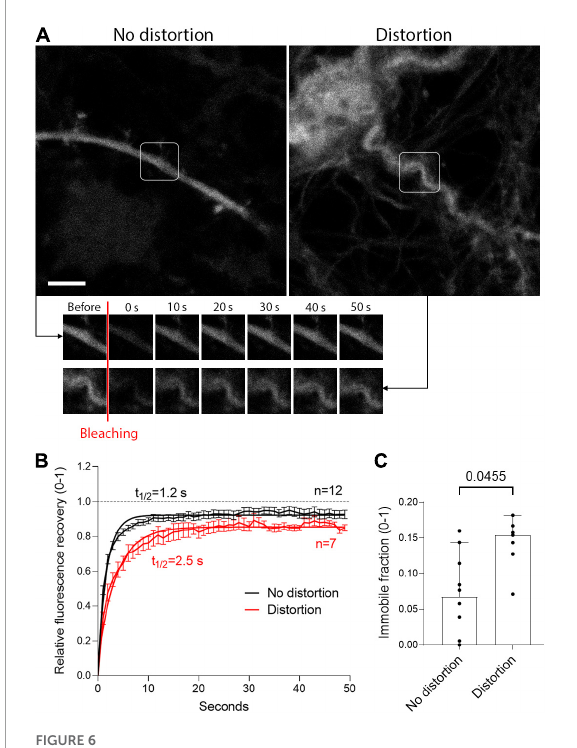
FIGURE6 Delayed diffusion in mechanically distorted fragments of dendrites. (A) Enhanced green fluorescent protein (eGFP) expression under the control of the neuron-specific synapsin promoter in neurons without mechanical distortion (left) and after distortion (right), with images at several time points after bleaching. Scale bar: 5 µ m. (B) Fluorescent recovery after photobleaching (FRAP) with one-phase exponential regression fitting demonstrates doubled recovery halftime of EGFP after mechanical deformation (values represent mean ± SEM). (C) Significant increase in the immobile fraction at the plateau of the FRAP curve. All values represent median ± 95% CI, Mann-Whitney U-test, exact p -value is presented on the graph (if below 0.05). The number of analyzed neurons in each group is indicated by the symbol points in the graph (for the non-distorted group, n = 12 neurons; for the distorted group, n = 7